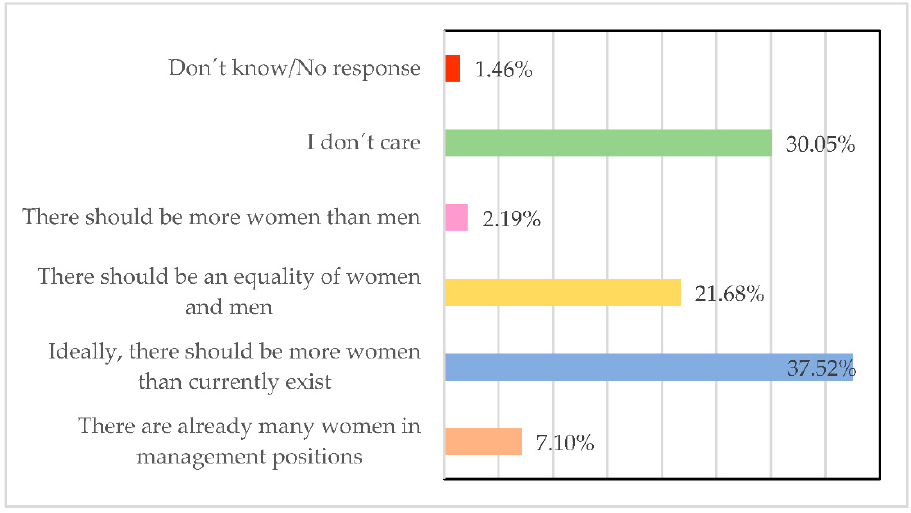
Figure 3. Number of women in managerial positions in your company. Source: Own elaboration.